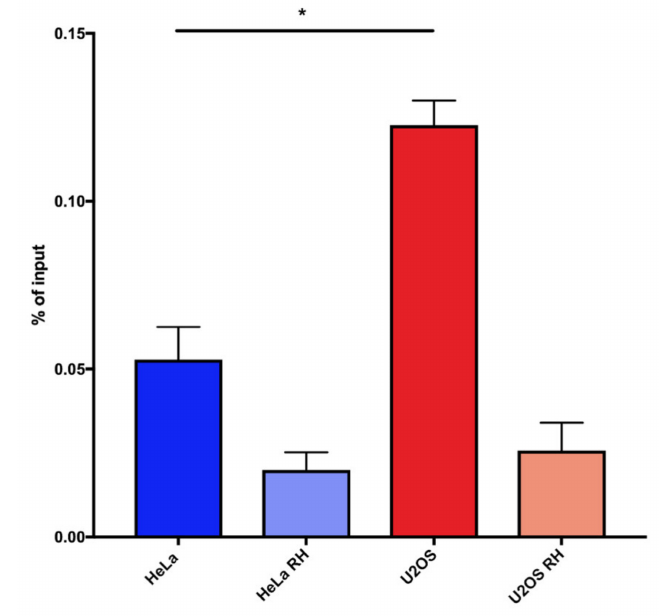
Figure 3. Telomeric DNA:RNA hybrid detection in HeLa and U2OS cells using TeloDRIP-qPCR. Bars and error bars are averages and SEM from four experiments. p -values are computed using one-way ANOVA (* p <